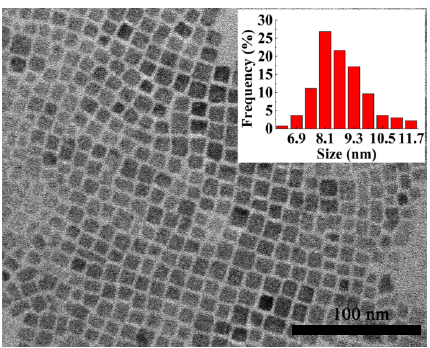
Figure 1. TEM of CsPbBr 3 nanocrystals (NCs). The inset shows the size distribution of CsPbBr 3 NCs.